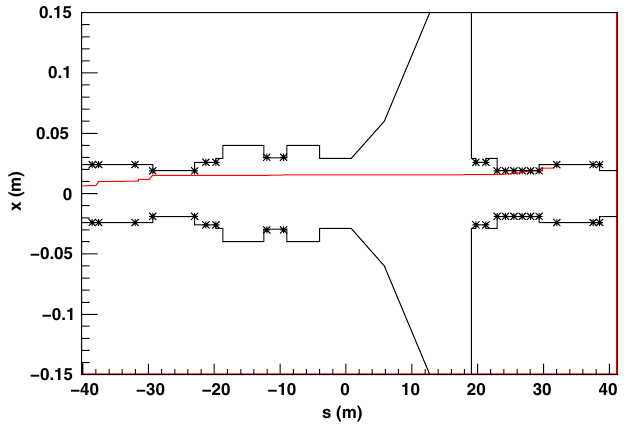
FIG. 8. (Color) A possible MBX.4L2 (D1) dipole setting which is dangerous for the ALICE beam pipe and interaction region magnets, where s ¼ 0 corresponds to the interaction point and the center of the experimental cavern.